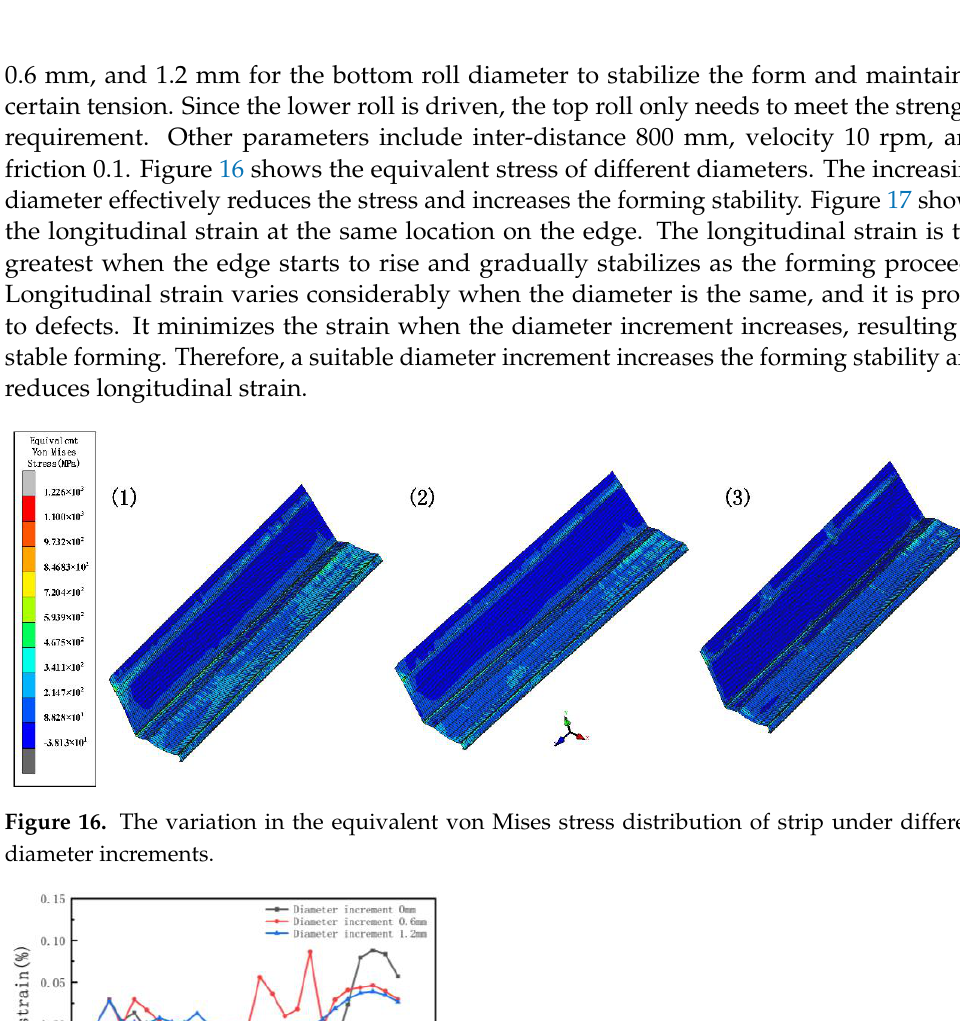
Figure 15. ( a ) Displacement X of strip in 3 friction coefficients; ( b ) cross – section of 3 friction coeffi- cients.